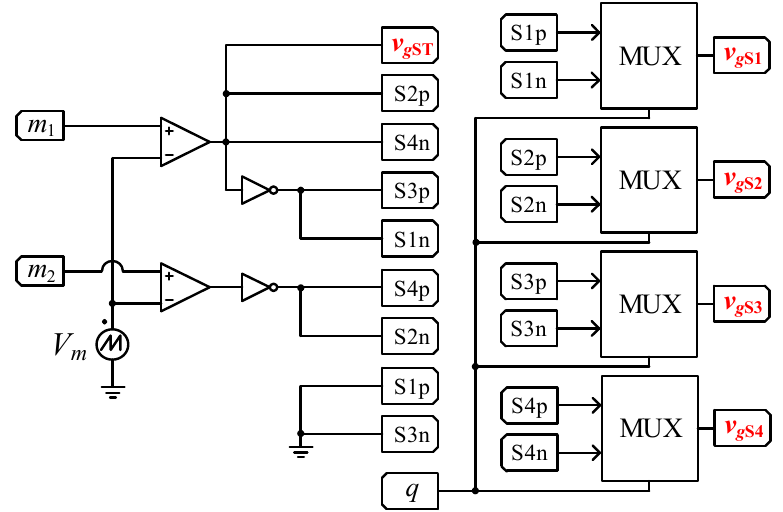
Figure 4. PWM modulator for the tri-state buck – boost mode of operation.